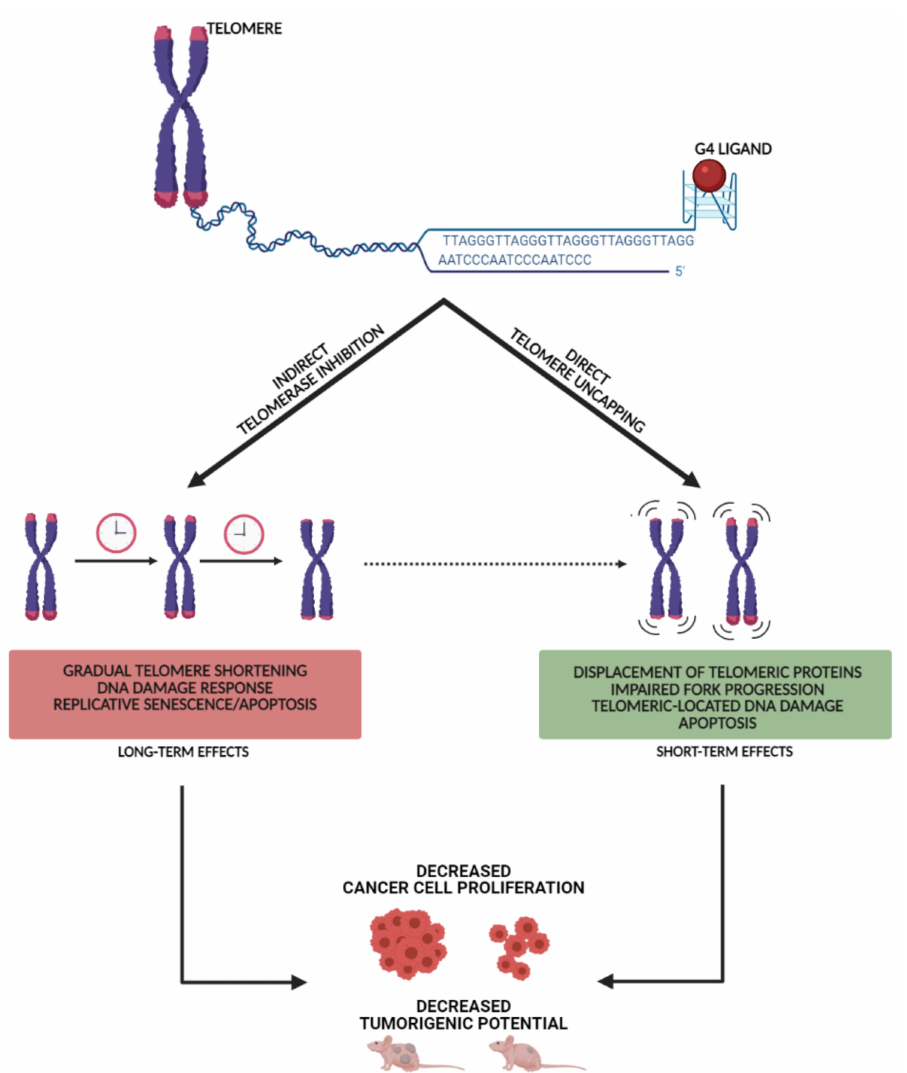
Figure 2. Schematic representation of the dual, sometimes interconnected (dashed arrow), path elicited by ligand-mediated stabilization of telomeric G4 (created with